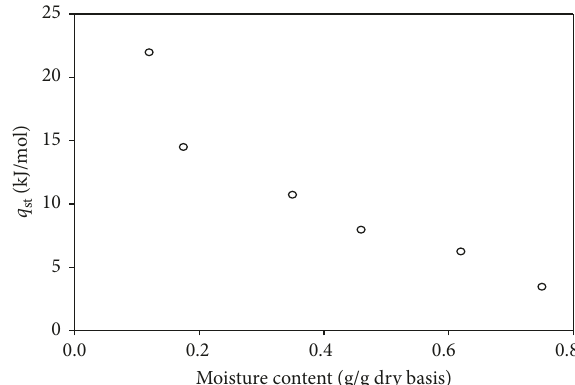
Figure 6: Isosteric heat of sorption ( q st ) of millet flour as a function of moisture content.